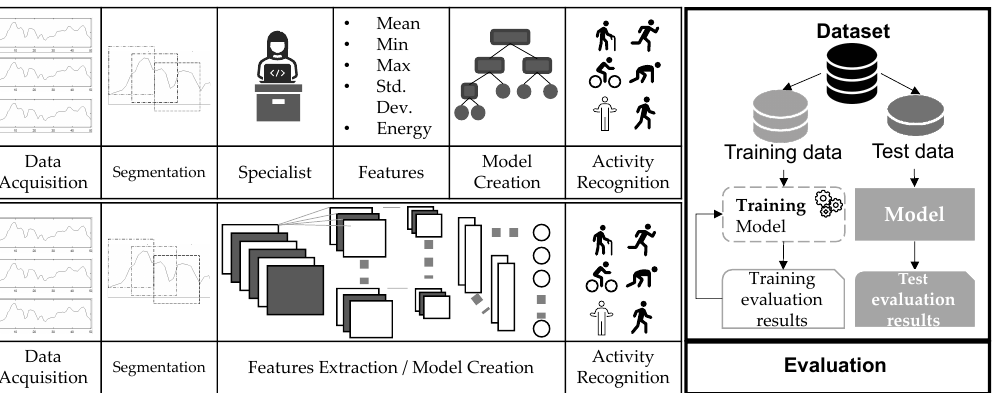
Figure 1. The common methodology used in HAR: Data acquisition, segmentation, feature extraction, classification and